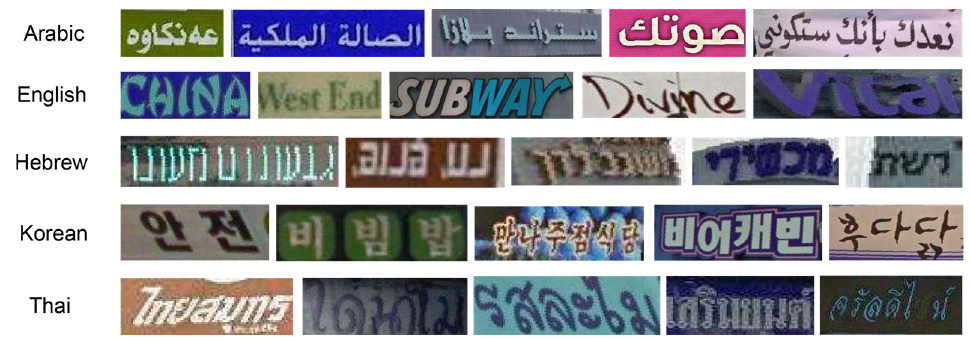
Figure 1. Sample dataset example.